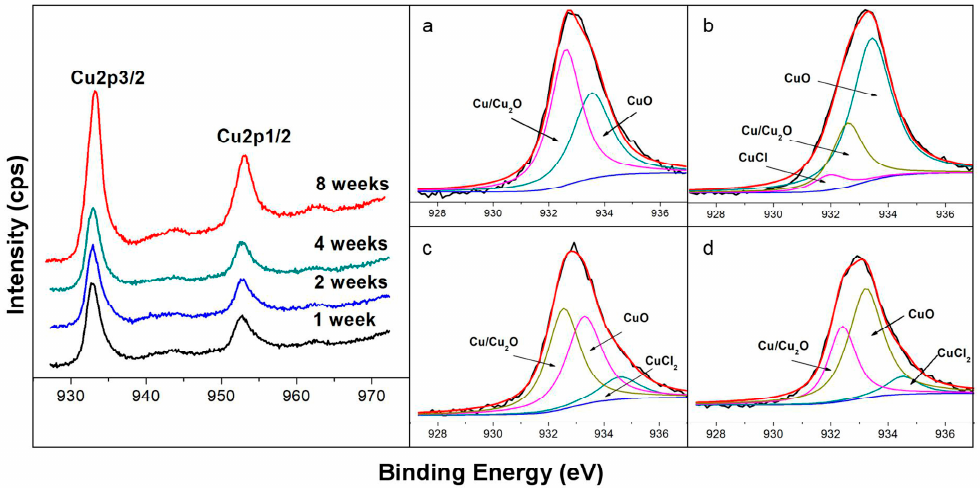
Figure 1. Cu XPS spectra of the corrosion product layer on the surface of the 90/10 Cu-Ni alloy in the natural seawater for different days: ( a ) Core-level Cu2p3/2 spectrum for 7 days; ( b ) core-level Cu2p3/2 spectrum for 14 days; ( c ) core-level Cu2p3/2 spectrum for 28 days; ( d ) core-level Cu2p3/2 spectrum for 56 days.